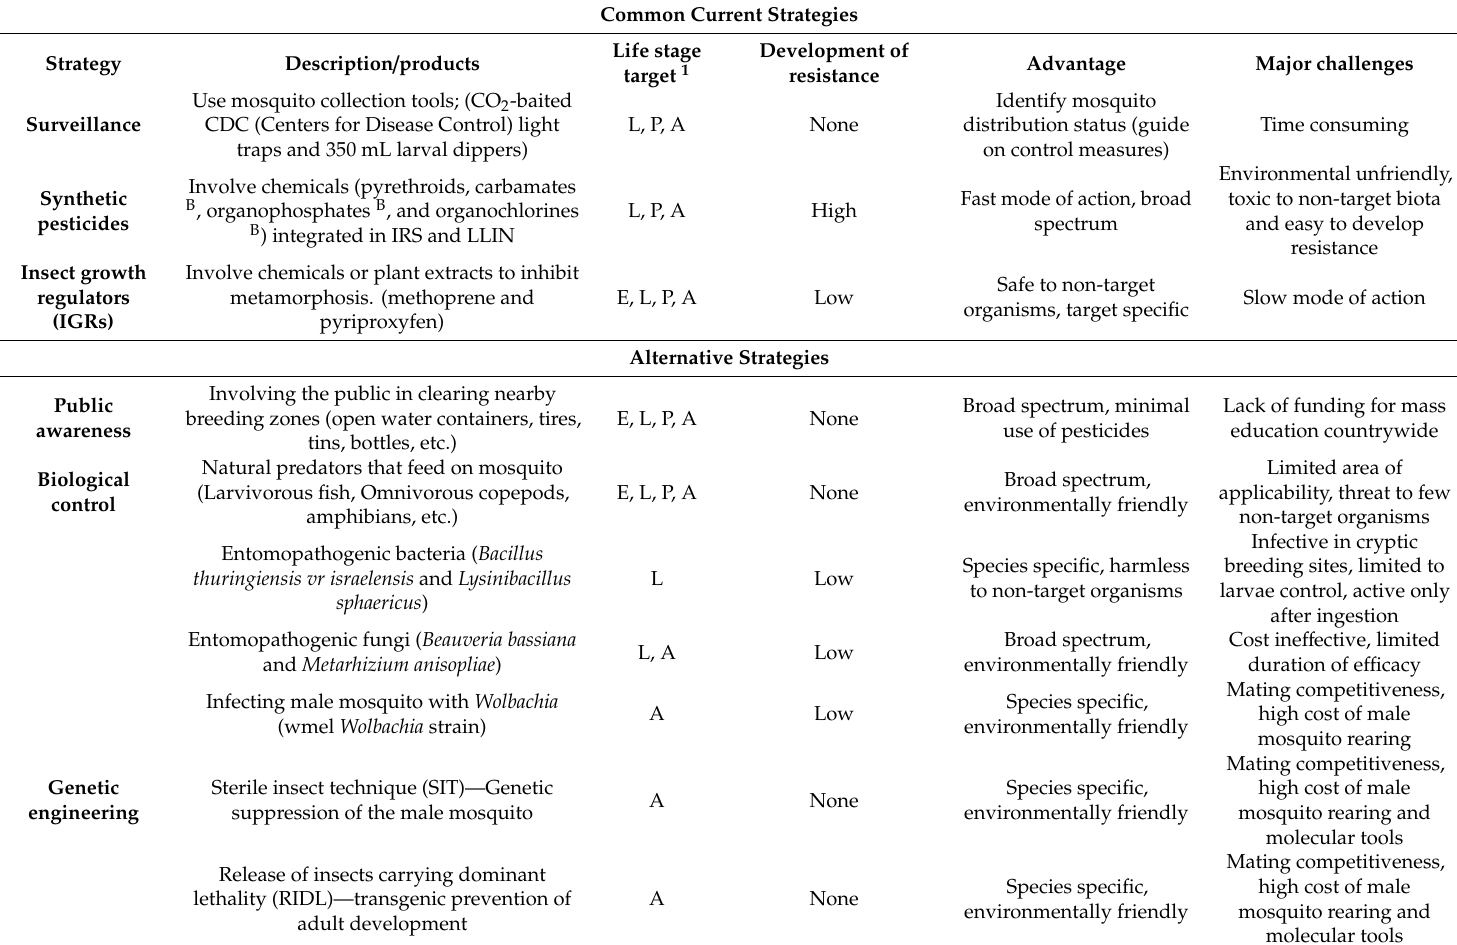
Table 3. Summary of the common mosquito control strategies in Kenya and proposed